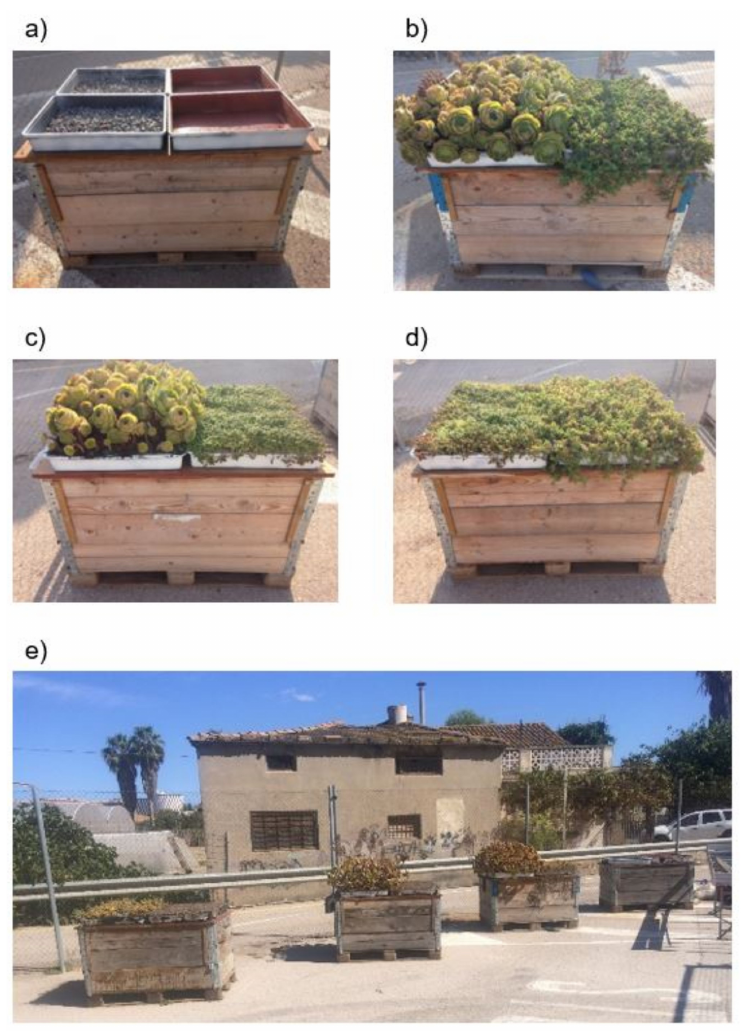
Figure 2. Experimental roofs over structures composed of two attached cabins covered with: ( a ) conventional covers: coarse gravel and red-polymer; green covers: ( b ) Aeonium and Aptenia , ( c ) Aeonium and Sedum , ( d ) Sedum and Aptenia ; ( e ) general view of the distribution of four structures of the eight of the